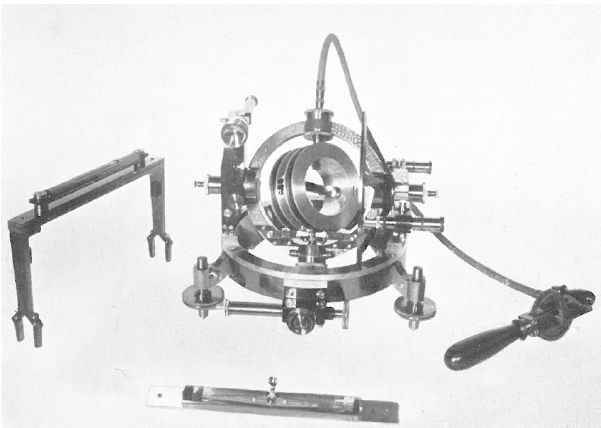
Figure 7. Earth inductor by Schulze, Potsdam. Source: Hell- mann (1912).